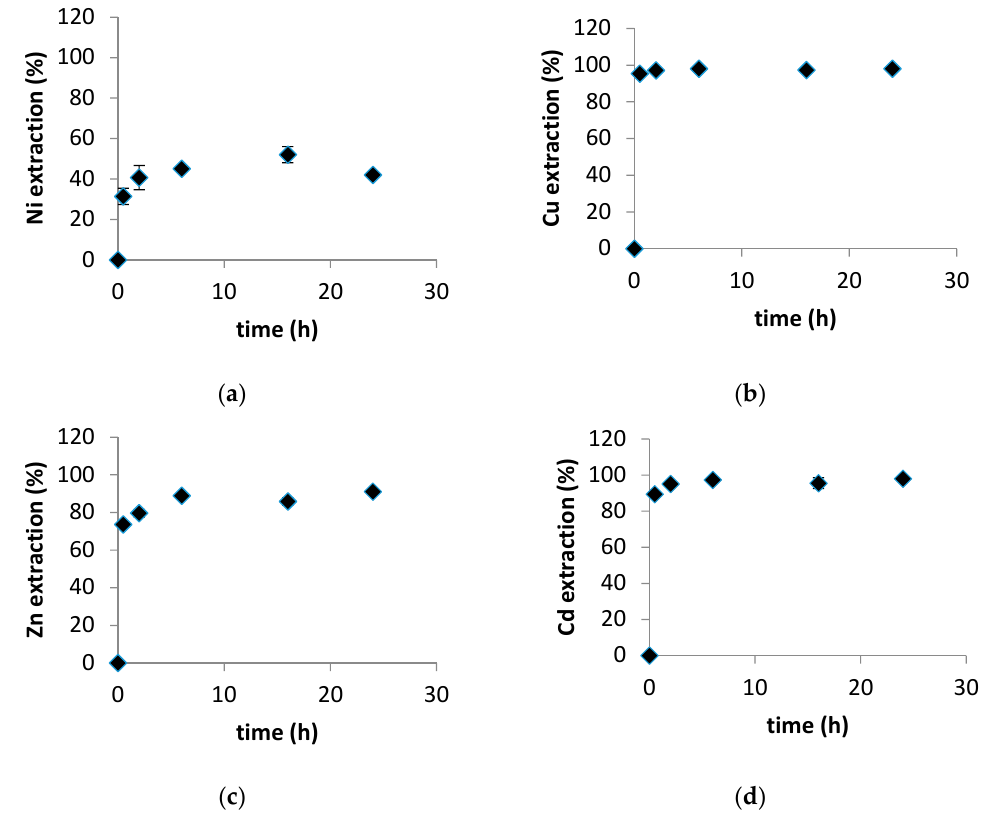
Figure 2. Kinetics of ( a ) Ni, ( b ) Cu, ( c ) Zn and ( d ) Cd adsorption with Adsorbsia As600 sorbent ( n = 2).